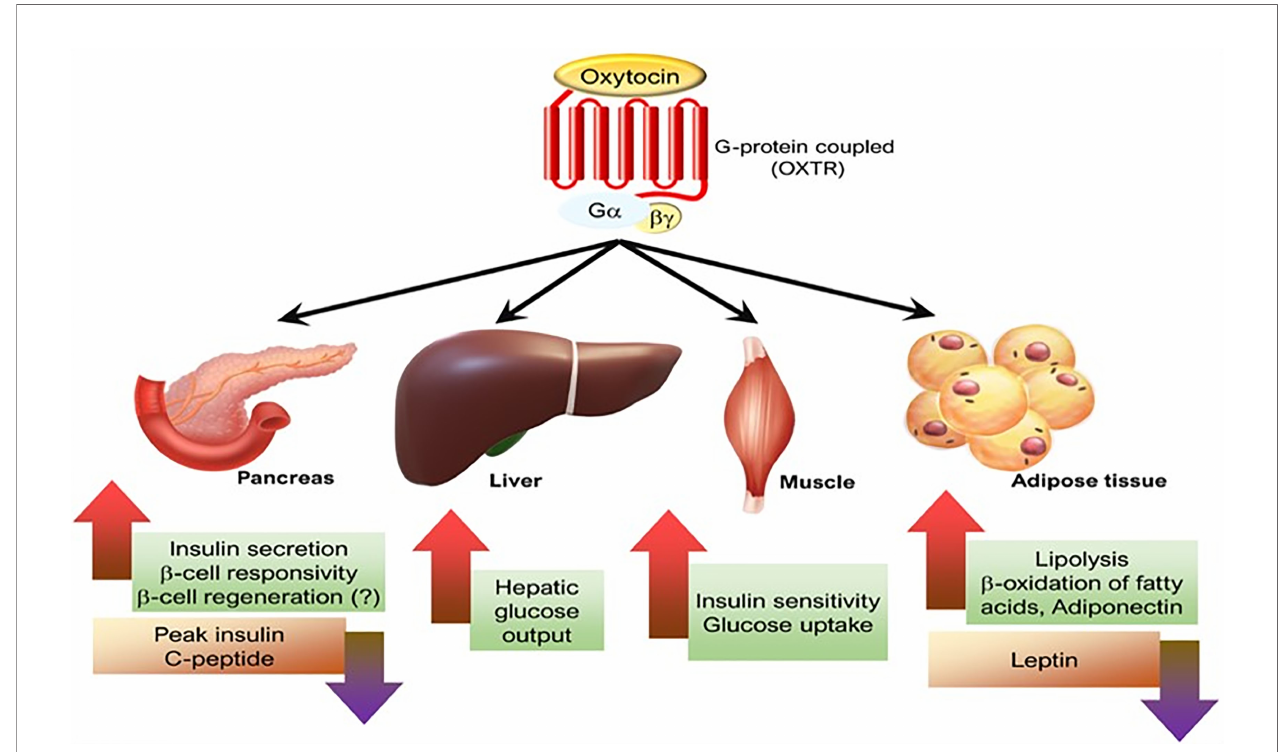
FIGURE 5 | The effects of oxytocin on various metabolic organs. [Figure originates and adapted from article